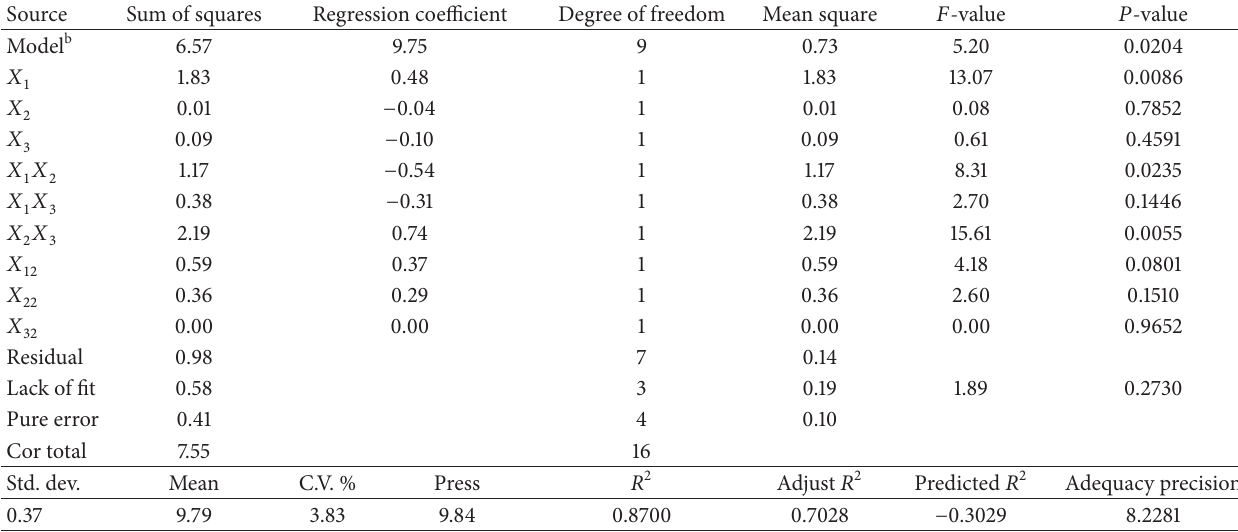
Table 2: Test of significance for regression coefficient and the credibility analysis a